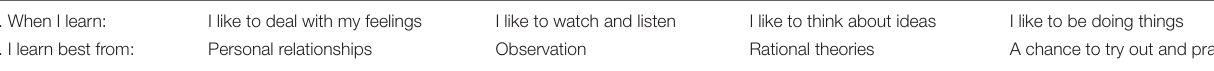
TABLE A1 | Examples from Kolb’s Learning Style Inventory